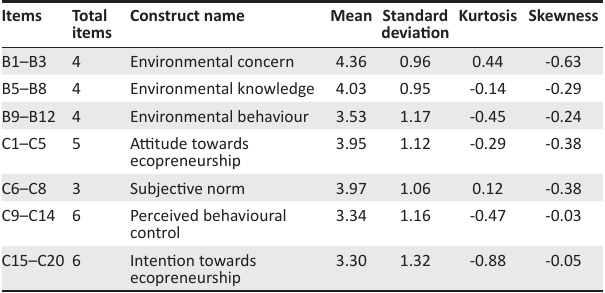
TABLE 4: Descriptive statistics construct summary.